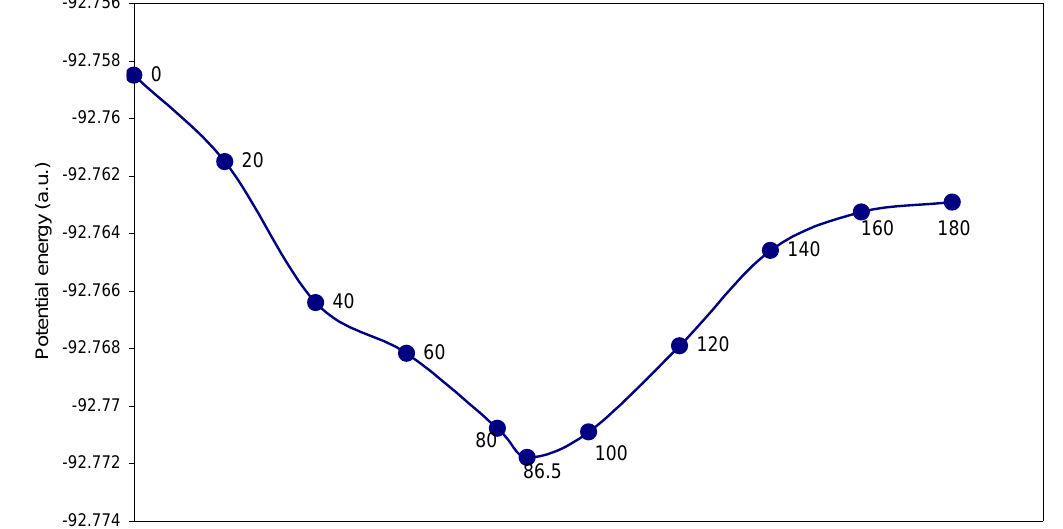
Figure 8. Plot of potential energy as a function of torsional angles in fluorine